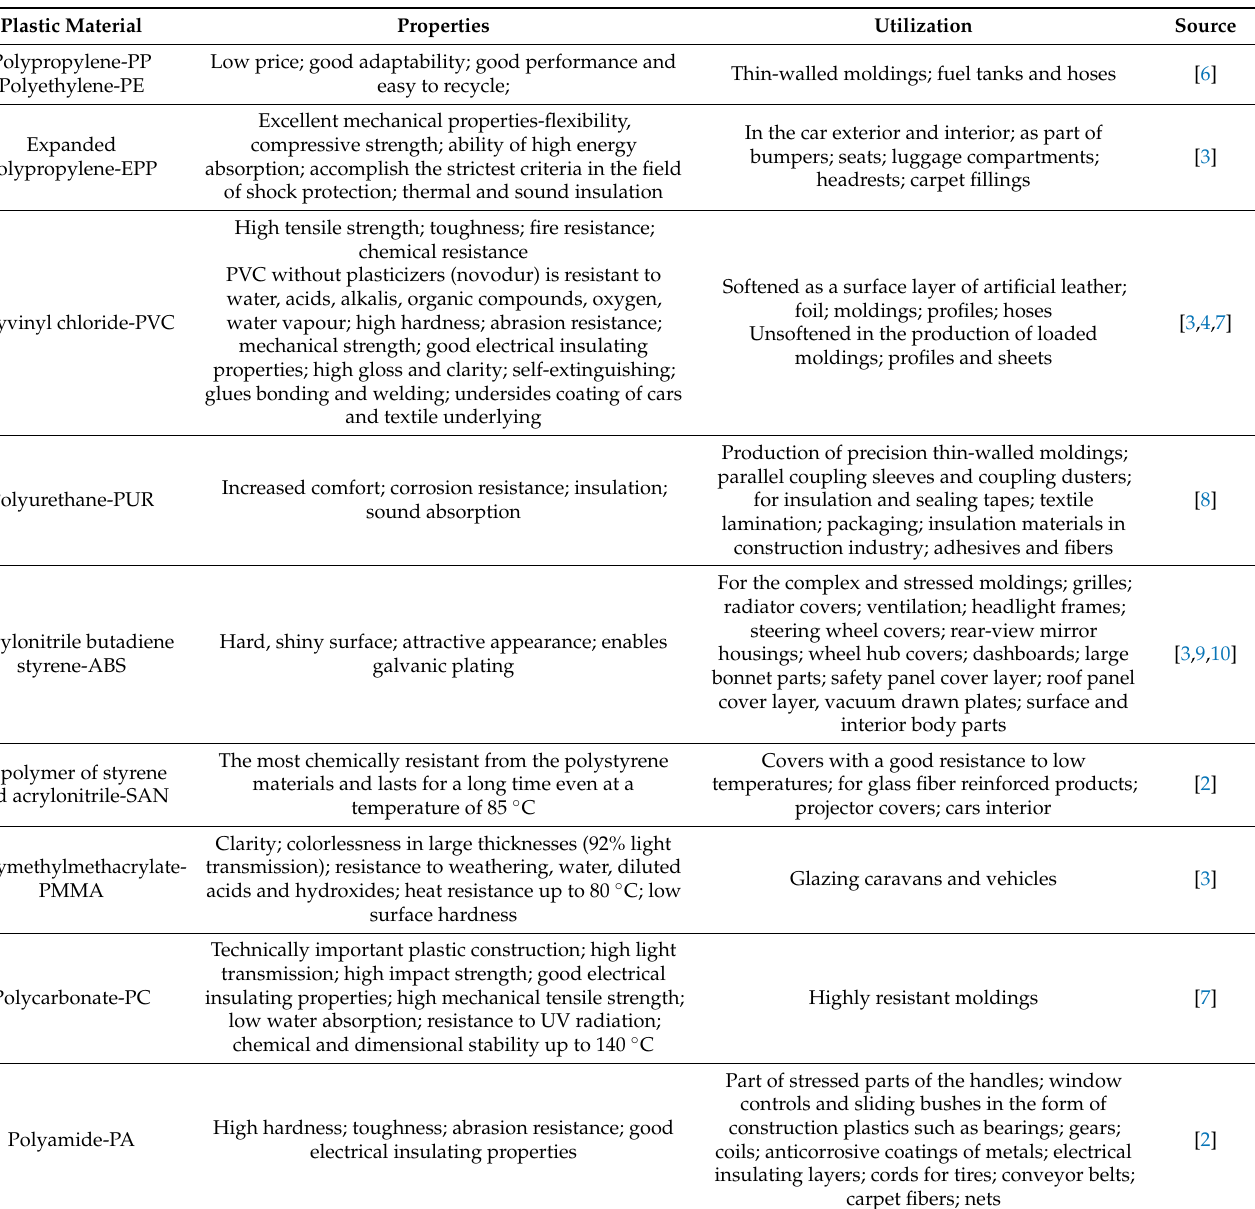
Table 1. Plastic materials used in the automotive